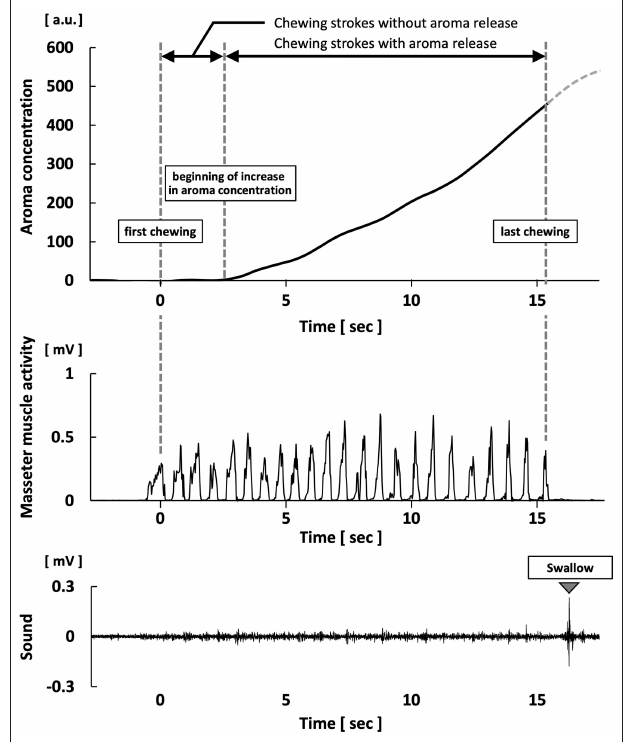
FIGURE 1 | Waveforms of aroma concentration, masseter muscle activity, and swallowing sound during gummy jelly